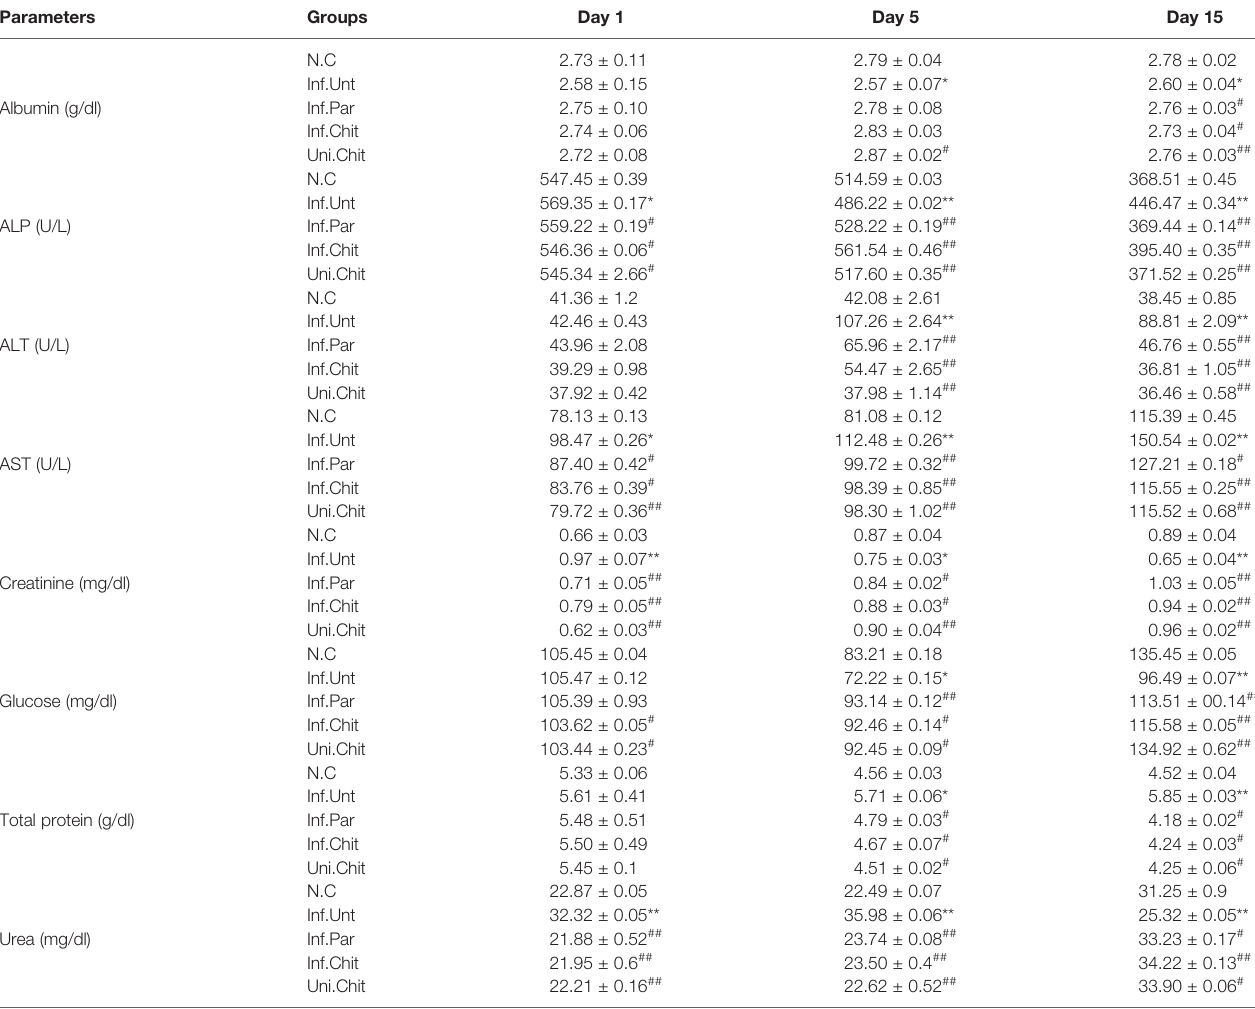
TABLE 1 | Changes in serum biochemical parameters of C. parvum -infected mice following chitosan treatment. Parameters